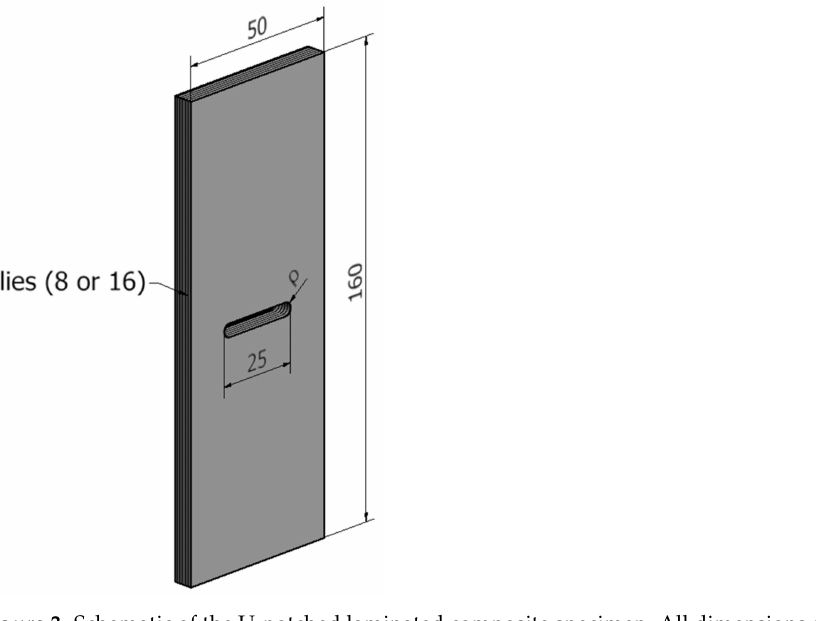
Figure 3. Schematic of the U-notched laminated composite specimen. All dimensions are in mm. The lay-up configurations are (0) s , (0/90/0/90) s , and (0/90/ ± 45) s